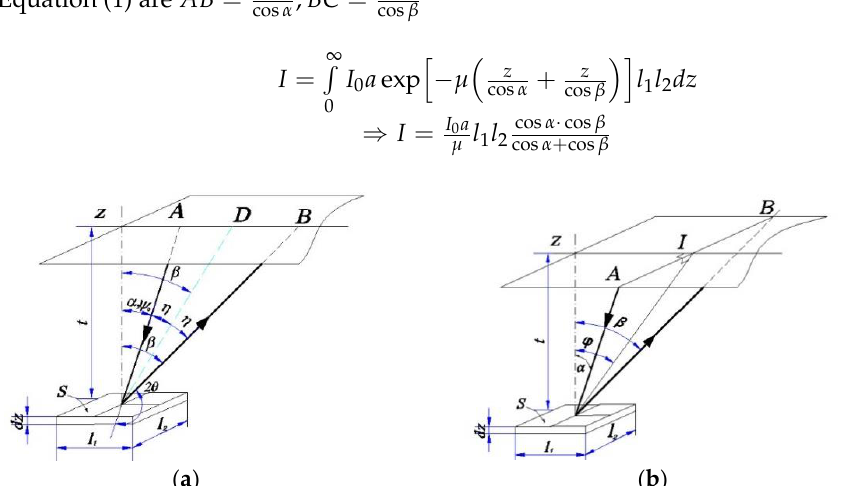
Figure 1. X-ray diffraction methods. ( a ) Iso-inclination method; ( b ) Side-inclination method.